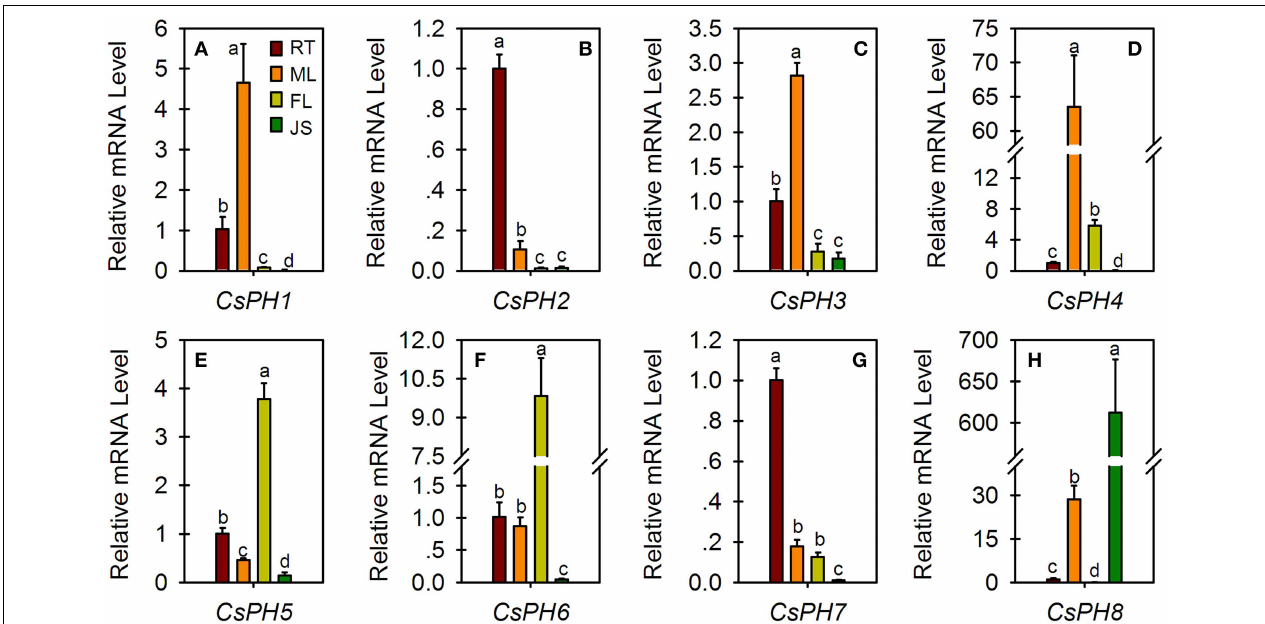
FIGURE 4 | Relative transcript levels of eight CsPH genes in different citrus tissues or organs. All qRT-PCR values are the average ± Se of three replicates. Different lower-case letters on the error bar in each gene indicate significant differences at P < 0 . 05 in Duncan’s multiple range test.